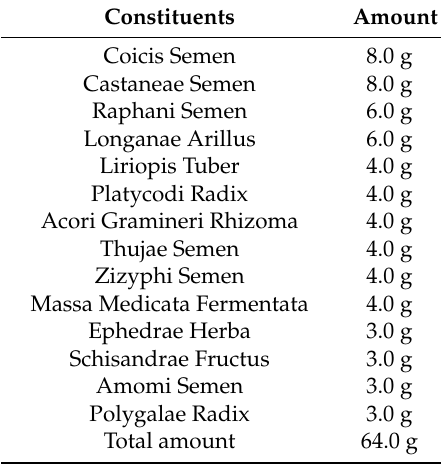
Table 1. The composition of